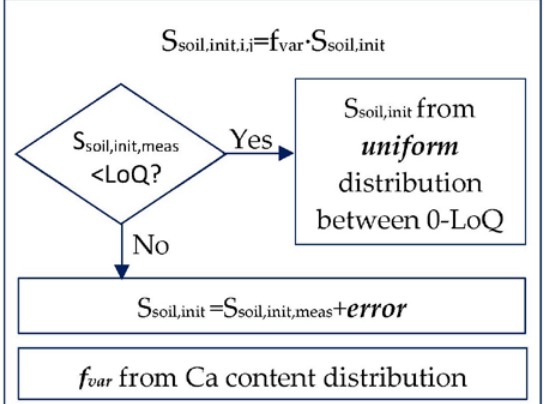
Figure 7. Method for estimating initial soil concentration for each pollutant.